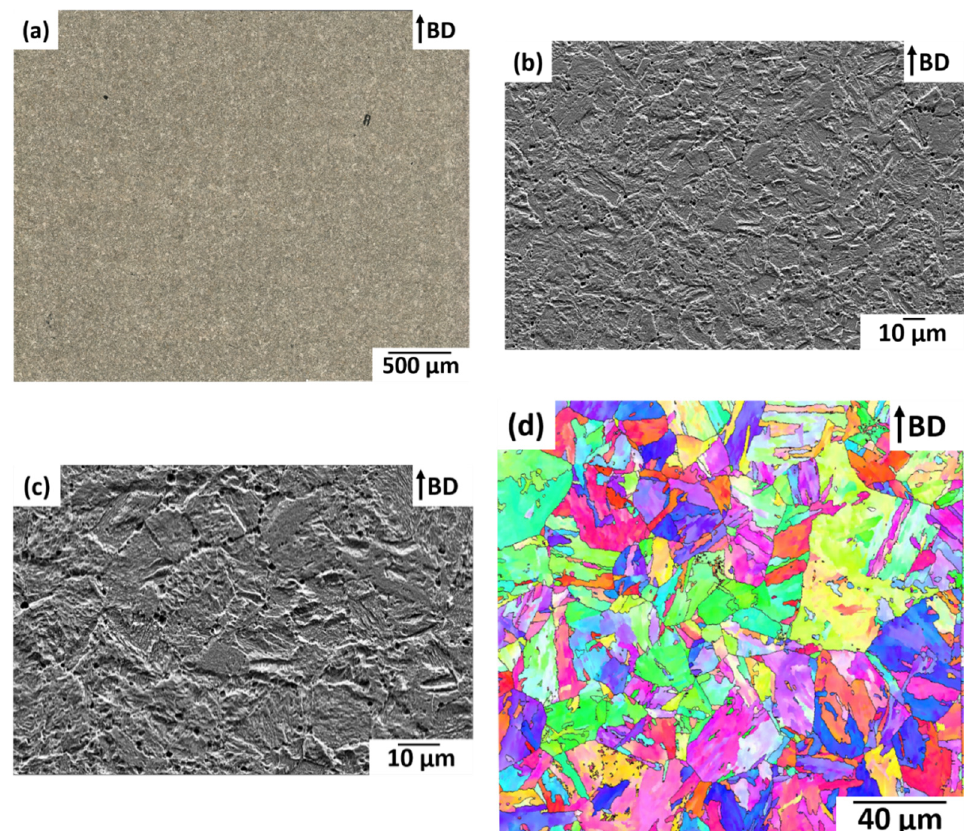
Figure 7. ( a ) Optical micrograph, ( b , c ) SEM micrograph and ( d ) EBSD micrograph of the heat- treated sample.